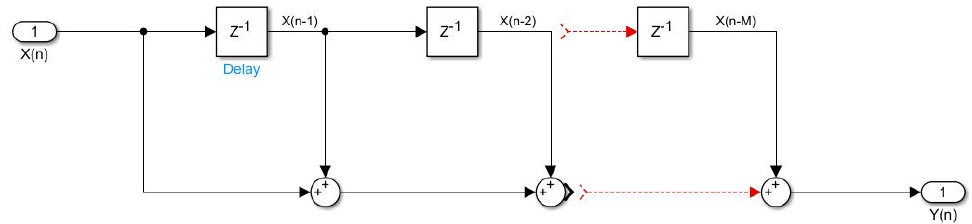
Figure 5. Illustration of the moving-average calculation.